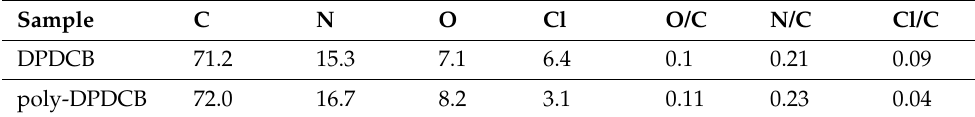
Table 1. Elemental analysis data (XPS). Concentration, at.